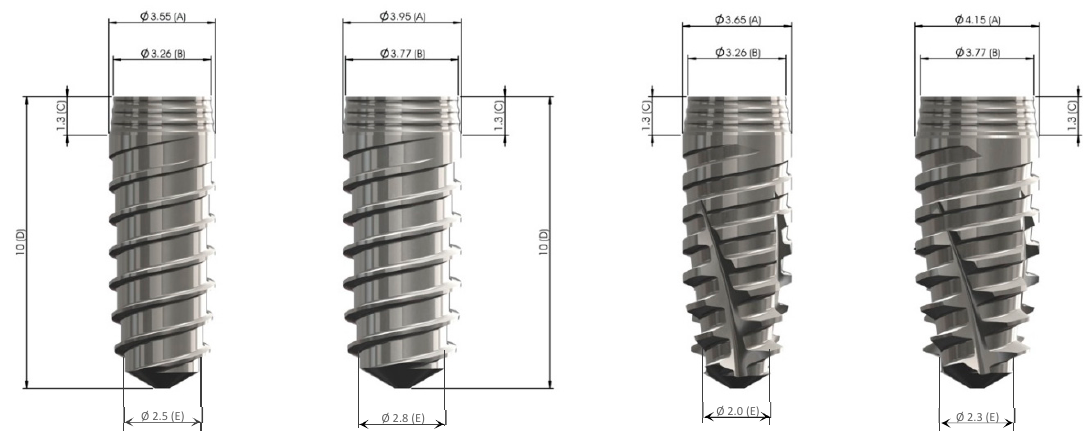
Figure 4. Macro-design of cylindrical (left) and tapered (right), both in 3.5- and 4.0-mm diameter.